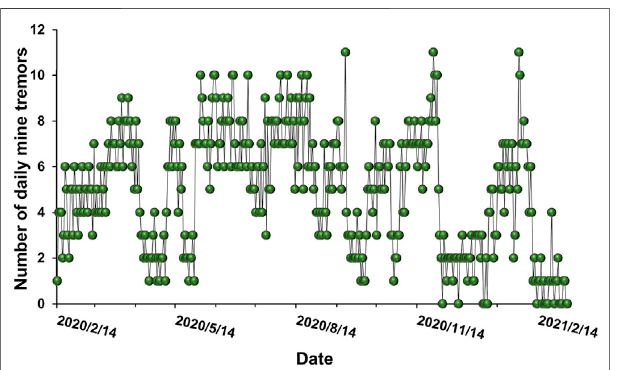
FIGURE 3 | Strong mining-related seismicities ( > 10 5